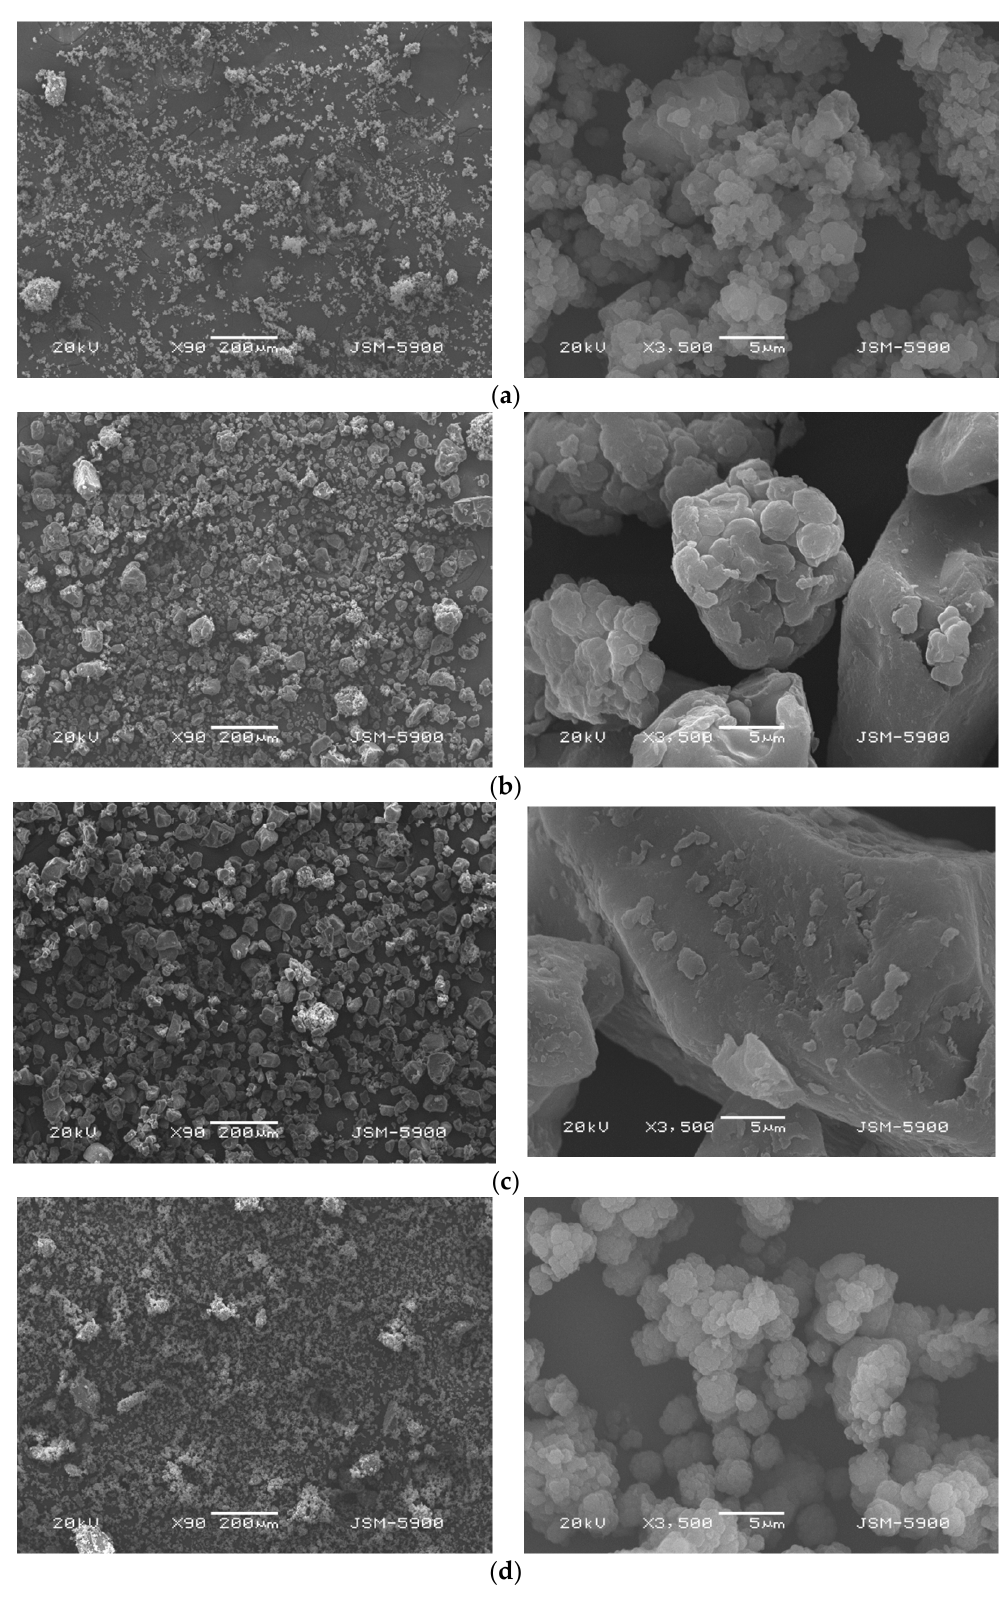
Figure 11. SEM images for hydrogel samples synthesized by FRP: ( a ) G311 (with Krytox); ( b ) G312 (without Krytox); ( c ) G313 (with Krytox); and ( d ) G314 (without Krytox).